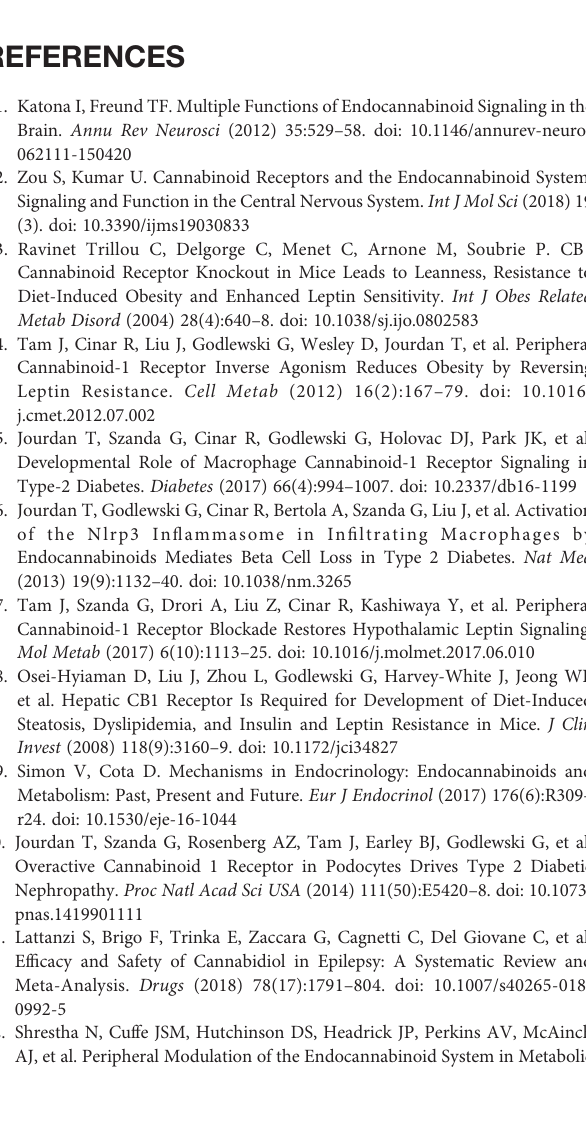
Supplementary Figure 3 | (A) Structure of GFP-tagged CB 1 R constructs used in microscopic experiments. (B) CMV promoter-driven heterologous expression of CB 1 Rs triggers extensive fi lopodium formation in Neuro 2a and HEK 293 cells as compared to TK-CB 1 R constructs. Images along the entire z-axis of cells were obtained as described for Figure 3 . To give a 2-dimensional representation of the entire cell, z-stacks were compressed into a single image using the ZProjection- maximal intensity algorithm of Image J (Fiji version). (Please note again that the brightness of images showing TK-CB 1 R variants was increased stronger than of CMV images for representative